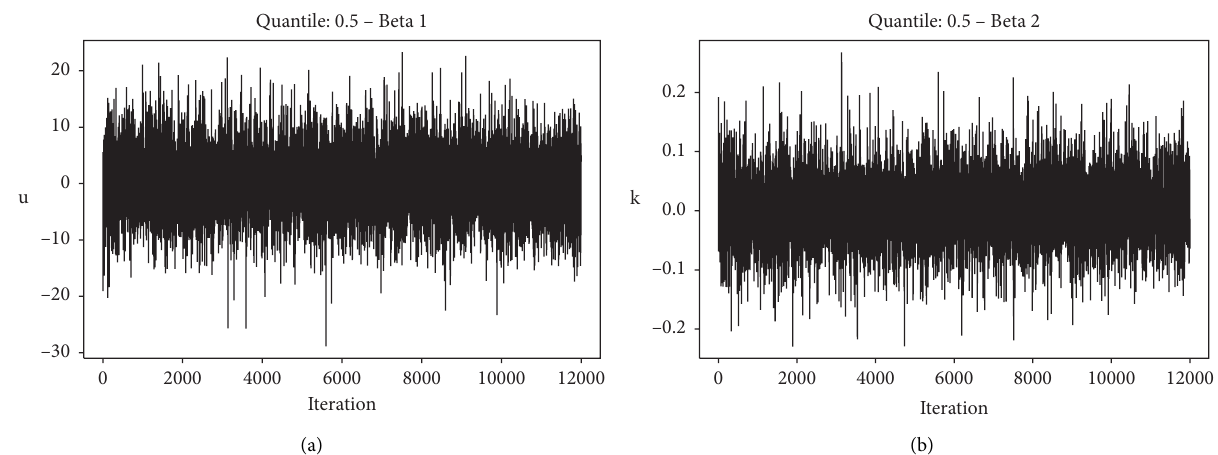
Figure 6: Traceplots of the MCMC chains for quantile regression: (a) curvature friction coefficient µ ; (b) wobble friction coefficient